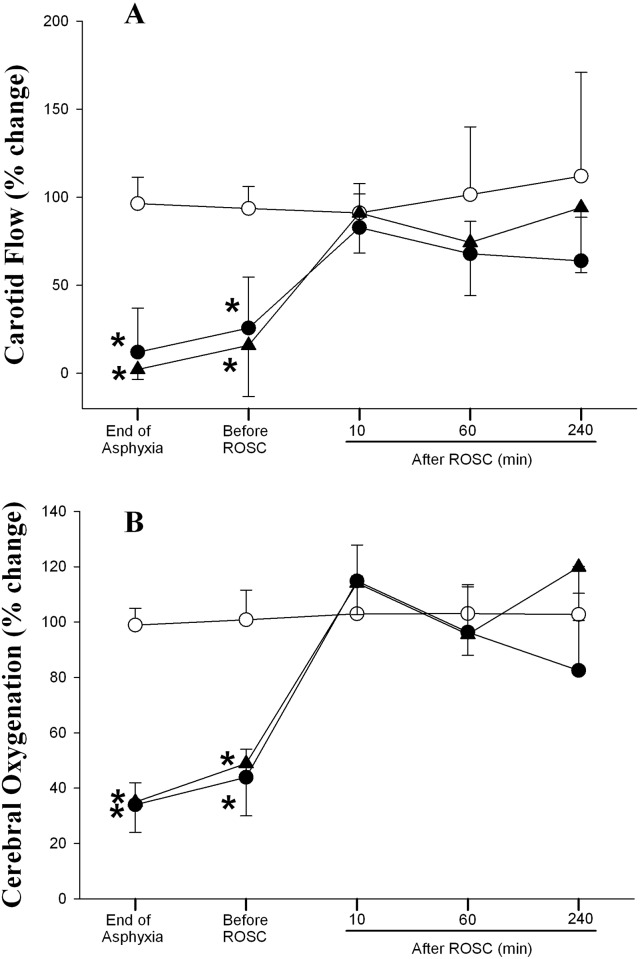
Percent changes from normoxic baseline in (A) carotid flow, and (B) cerebral oxygenation in sham (◯), SI+CC 90 (●), and SI+CC 120 (▴) groups during and after resuscitation.Each point represents mean±SD. *Significantly different from sham-operated group, p<0.05 (Tukey).